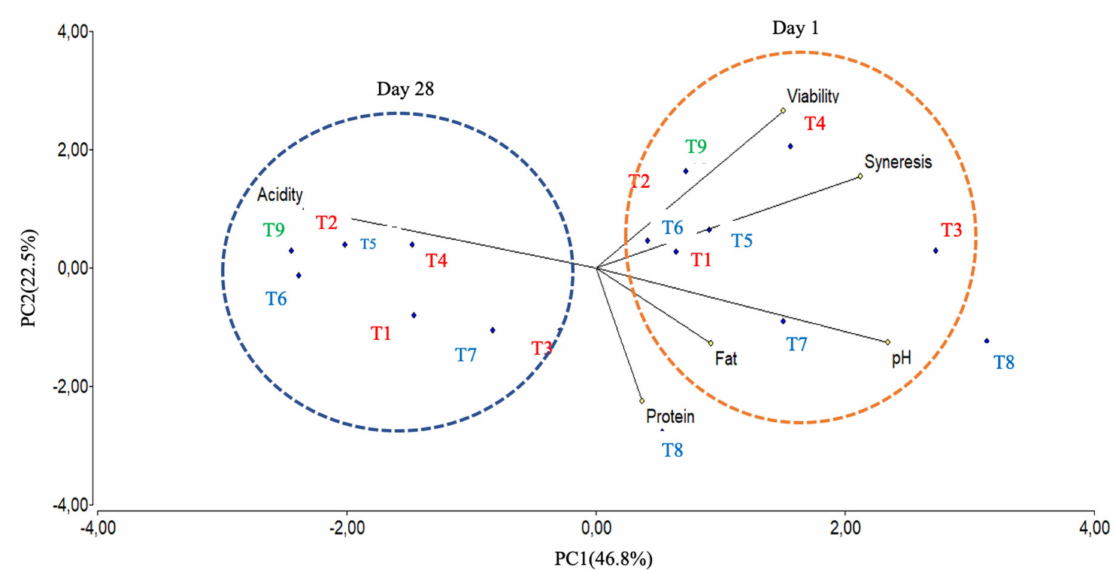
Figure 4. Principal component analysis of yogurt data at day 1 (red circle) and 28 of storage (blue